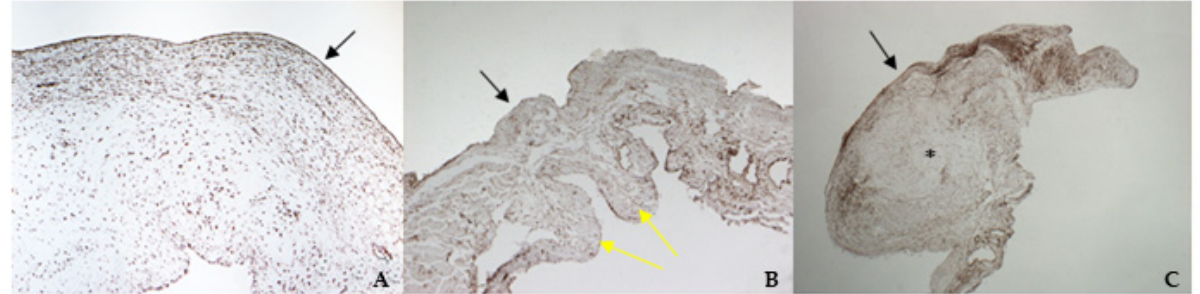
Figure 4. The picture shows positivity to vimentin (VIM) in bovine ( A ) (magnification: 5 × ) and healthy ( B ) (magnification: 5 × ) and pathological ( C ) (magnification: 5 × ) canine mitral valves. Black arrows indicate the atrial aspect, while yellow arrows indicate the origin of the cordae tendinae (ventricular aspect). *: area of myxomatous